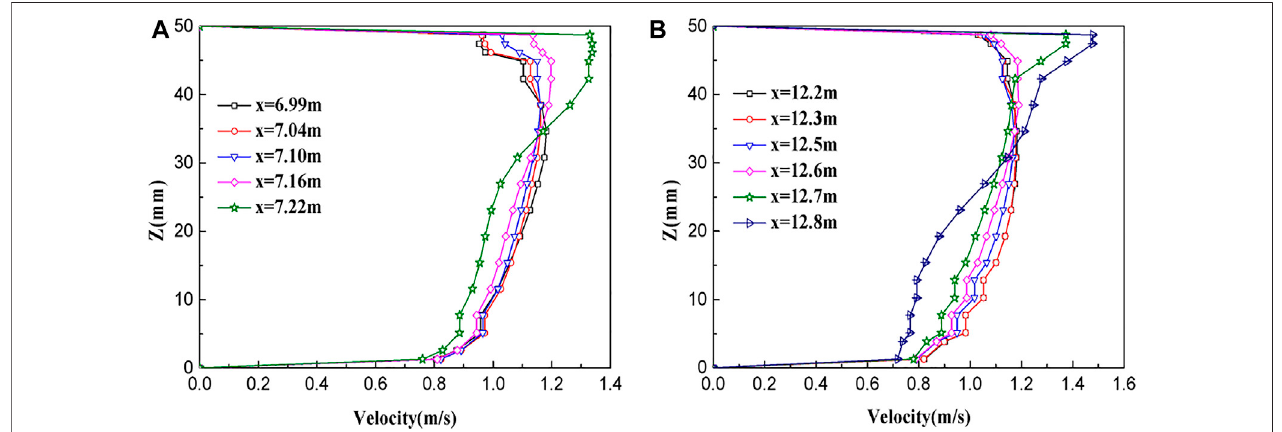
FIGURE 16 | Velocity distribution curves of (A) developing and (B) developed slugs ( V sg (cid:2) 1 m/s, V sl (cid:2) 1 m/s).